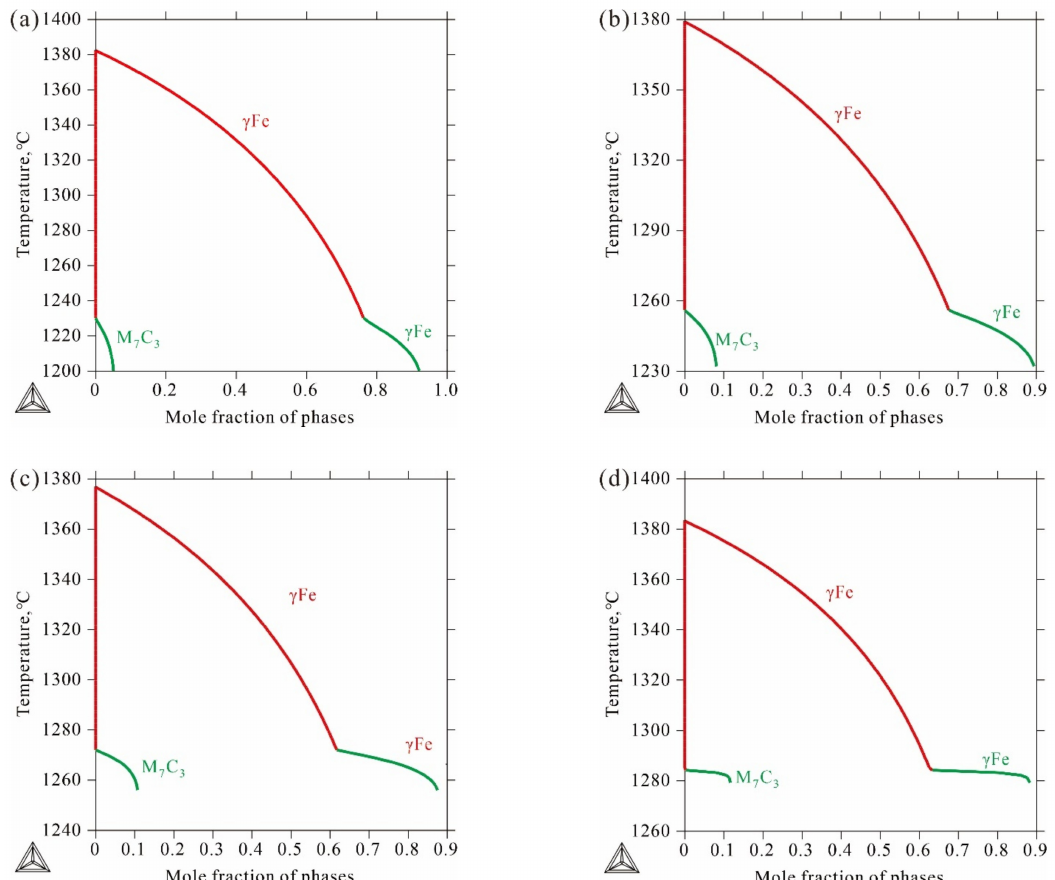
Figure 2. Calculated solidification paths of the CILs through the modified Scheil–Gulliver simulation. ( a ) CIL-1; ( b ) CIL-2; ( c ) CIL-3; ( d )